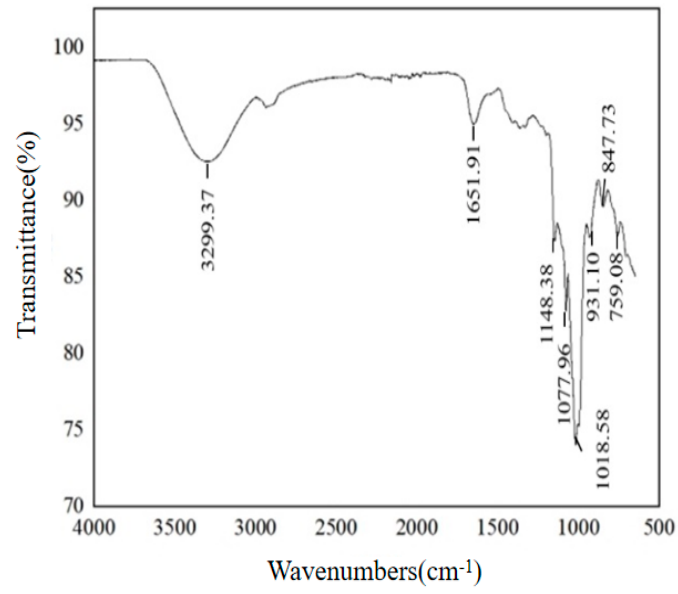
Figure 3. FT-IR spectra of SDF extracted from glutinous rice bran by the ultrasound-assisted enzy- matic method.